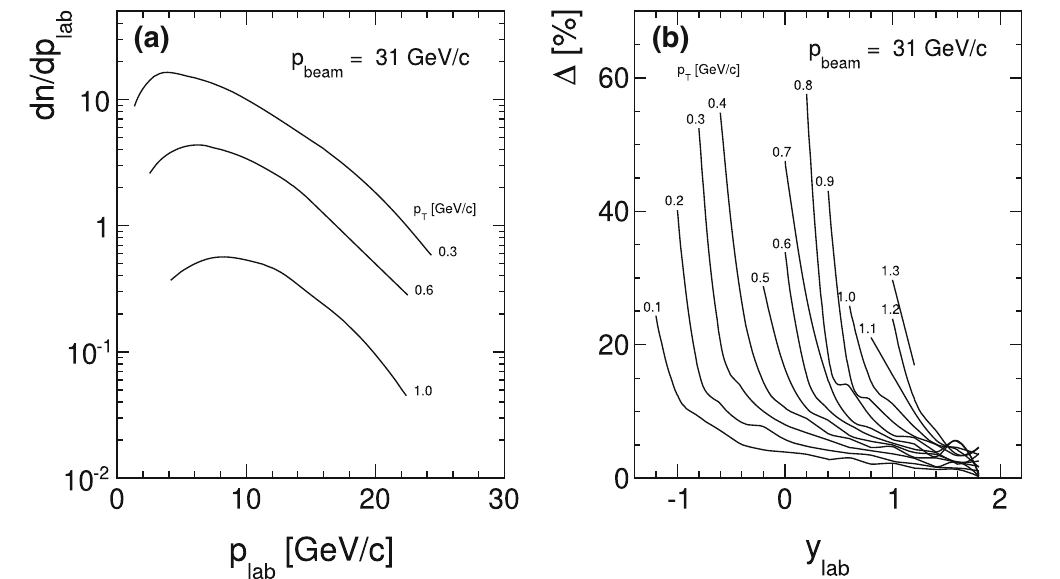
Fig. 64 a π − yields dn / dp lab as a function of p lab for beam momenta of 31 GeV/c and transverse momenta of 0.3, 0.6 and 1 GeV/c; b pre- dicted changes in percent of the cross sections for 3% upward modifi- Fig. 65 Cross sections f /σ inel as functions of p T and y lab for y lab = 0.0. The full lines represent the global interpolation, the data points the NA61 results. The broken lines are eyeball fits to these data demonstrating the smooth s -dependence of the